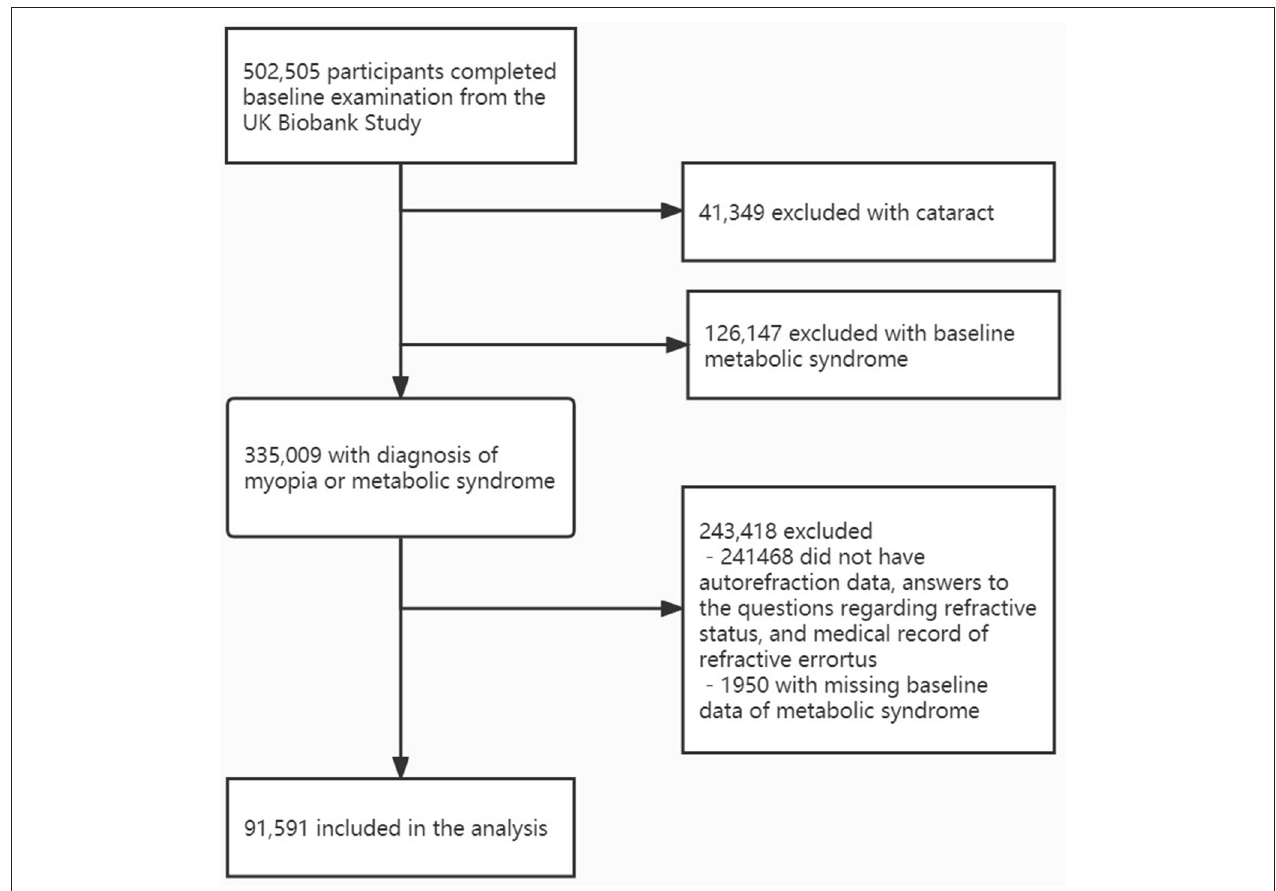
FIGURE 1 | Flowchart depicting inclusion of participants in this